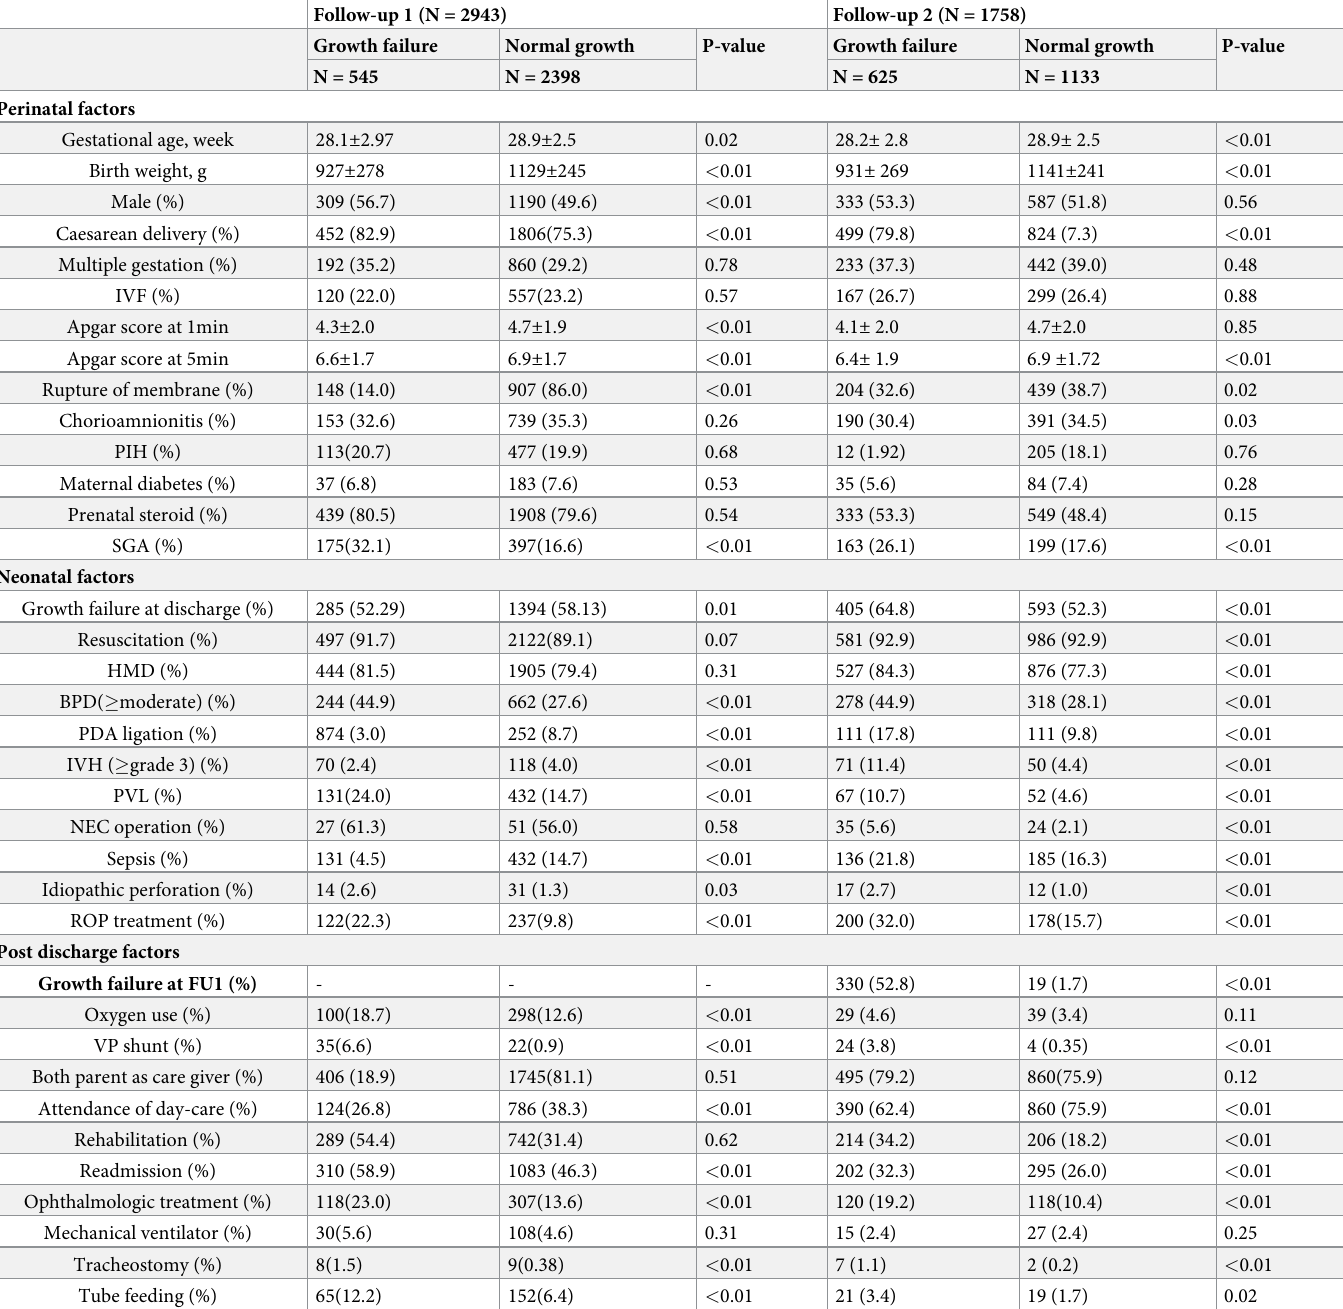
Table 1. Comparison of various factors between growth failure and normal growth at follow-up 1 and follow-up 2 by univariate